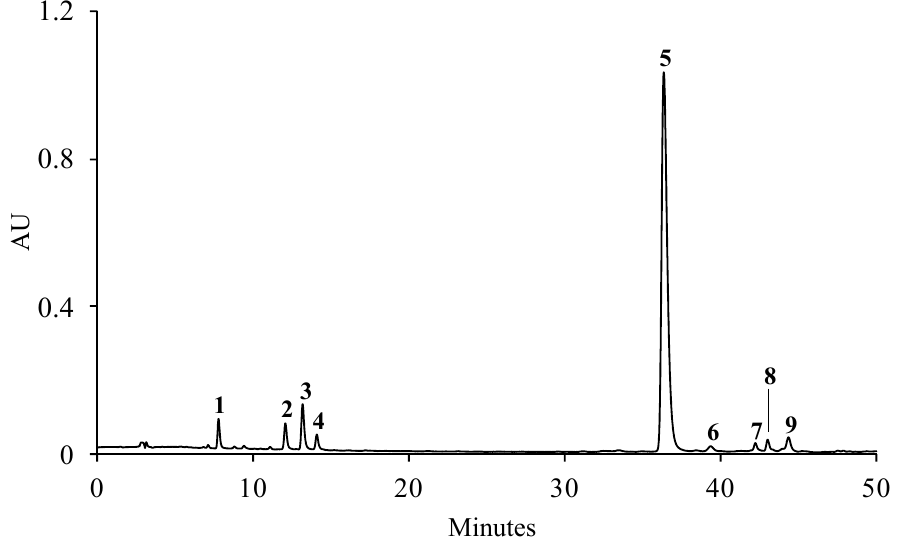
Figure 1. Representative HPLC-DAD chromatogram of the phenolic profile of the aqueous extract of S. betaceum leaves detected at 320 nm. ( 1 ) 3- O -Caffeoylquinic acid, ( 2 ) 4- O -caffeoylquinic acid, ( 3 ) chlorogenic acid, ( 4 ) caffeic acid, ( 5 ) rosmarinic acid, ( 6 and 9 ) unknown kaempferol glycoside derivatives, ( 7 and 8 ) unknown hydroxycinnamic acid derivatives.